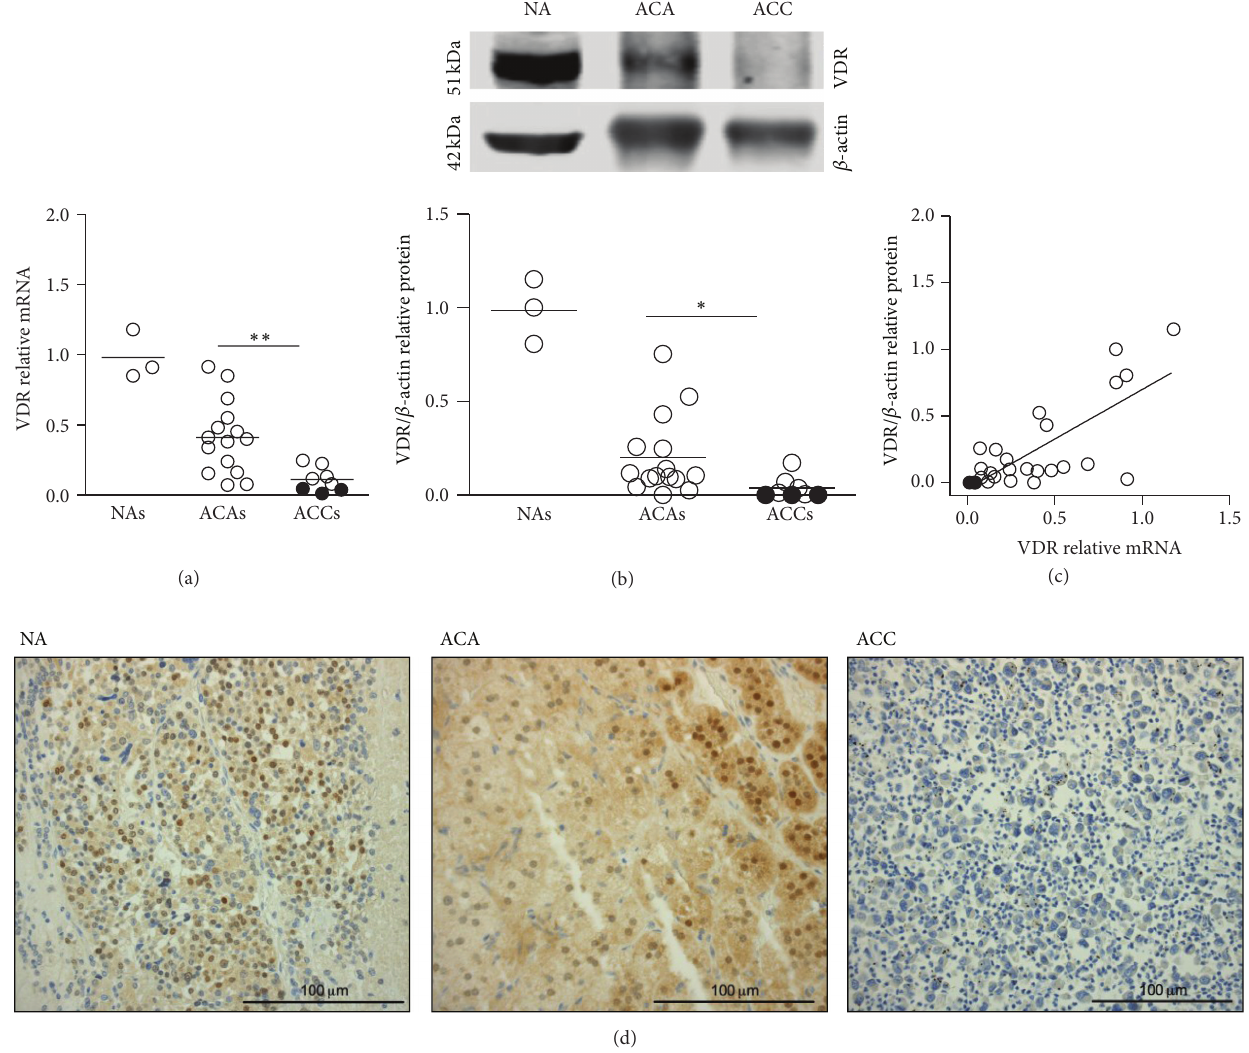
Figure 2: Expression of VDR in normal human adrenals, in adrenocortical adenomas (ACAs), and in adrenocortical carcinomas (ACCs). (a) Individual mRNA levels and means (horizontal bars) of VDR, measured by qPCR, in normal adrenals ( 𝑛 = 3 ), ACAs ( 𝑛 = 15 ), and ACCs ( 𝑛 = 8 ). (b) VDR immunoblot (above) in representative cases of a normal adrenal (NA), ACAs, and ACCs, and individual VDR/ 𝛽 - actin protein levels (below) in normal adrenals, ACAs, and ACCs. (c) Correlation between VDR mRNA and VDR protein levels in all tissue samples, including normal and neoplastic adrenal. (d) Immunohistochemical staining of VDR in a normal adrenal (left panel), one ACA (central panel), and one methylated ACC (right panel), showing clear VDR expression in NA, in a cortisol-producing ACA, in both the nucleus and predominantly the cytoplasm, and very weak VDR expression, limited to rare cells, in a cortisol-producing ACC. Sections were counterstained with hematoxylin. Black dots indicate methylated tissue samples. Mann-Whitney 𝑡 -test ACAs versus ACCs. ∗∗ 𝑃 < 0.01 ; ∗ 𝑃 < 0.05 . Spearman correlation 𝑟 = 0.56 ; 𝑃 < 0.003 𝑠